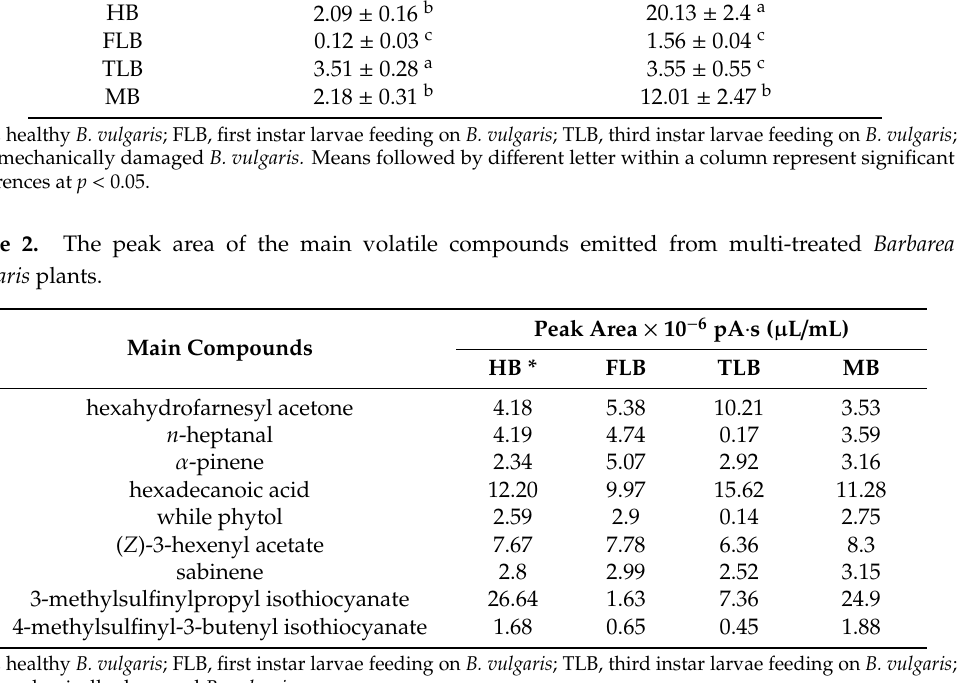
Table 1. Mean quantities (ng) ± SE of isothiocyanate from the headspace of multiple damaged Barbarea vulgaris plants. Major Active Compounds (ng) Treatment * 3-Methylsulfinylpropyl Isothiocyanate